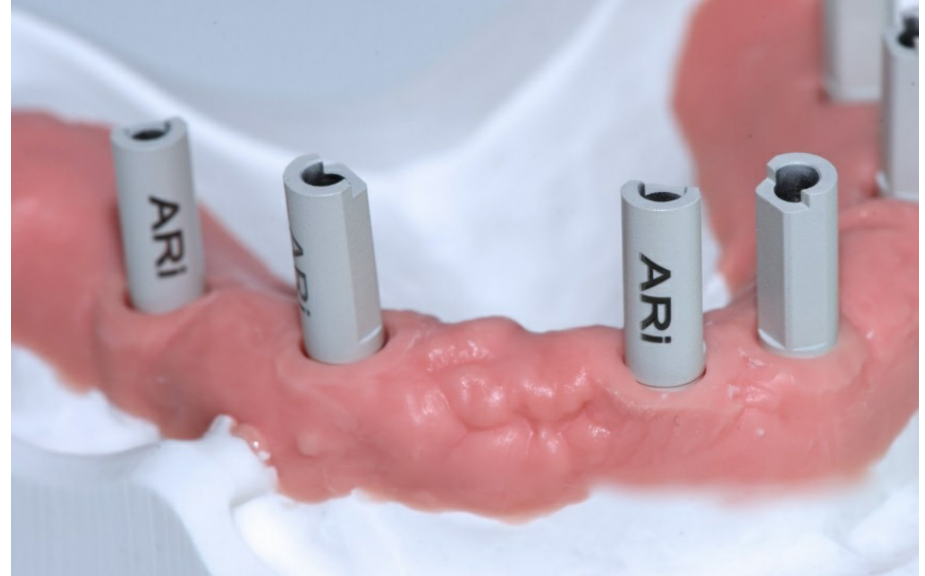
Figure 3. The SBs were all identical, 13 mm in height, and fabricated by the same manufacturer (Megagen, Gyeongbuk, Korea) with the scanning area in opaque white polyether-ether-ketone (PEEK).